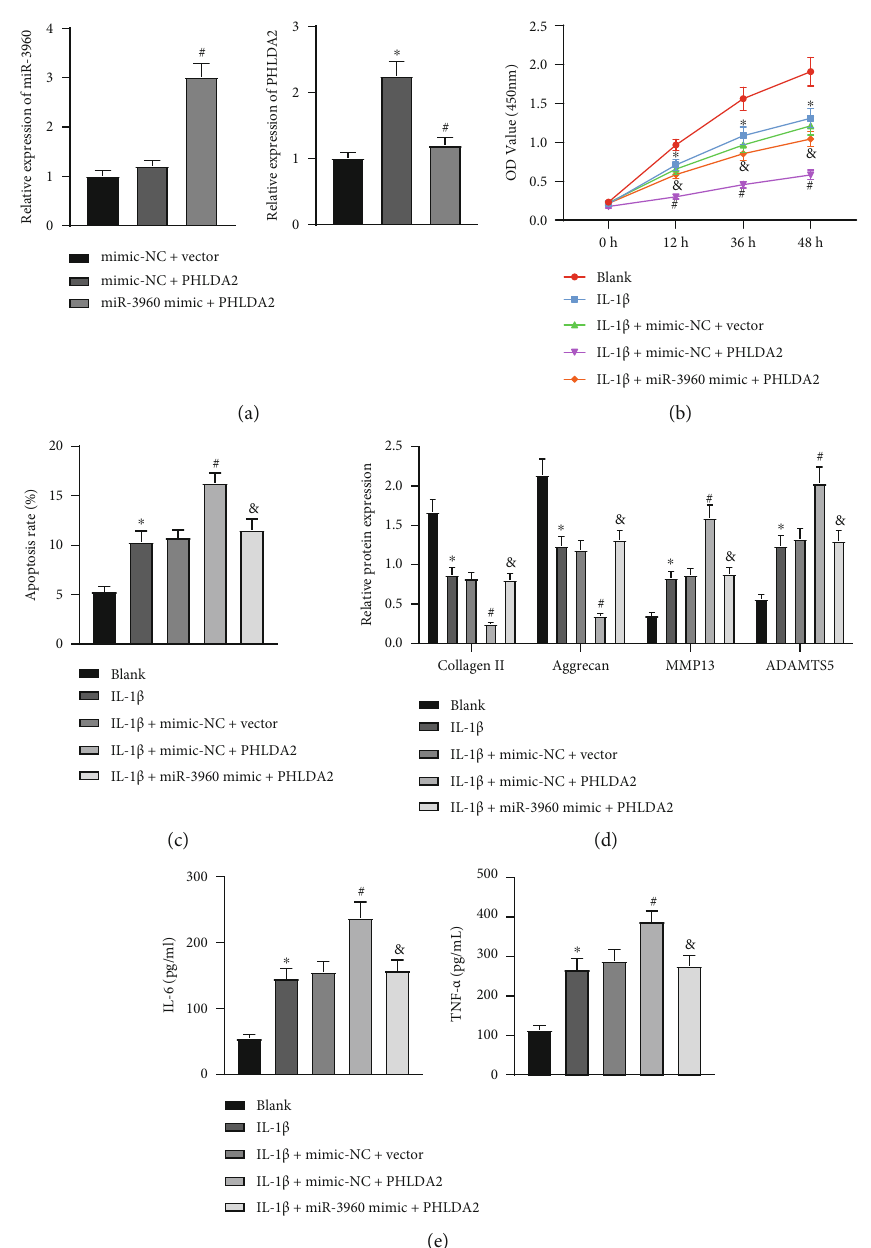
Figure 4: miR-3960 attenuates chondrocyte injury by inhibiting PHLDA2. Chondrocytes were transduced with miR-3960 mimic and/or PHLDA2A. (a) miR-3960 expression and PHLDA2 mRNA level in the chondrocytes determined by RT-qPCR. Chondrocytes were treated with IL-1 β and transduced with miR-3960 mimic and/or PHLDA2A. (b) Cell proliferation assessed by CCK8 assay. (c) Apoptosis assessed by fl ow cytometry. (d) Protein levels of collagen II, aggrecan, MMP13, and ADAMTS5 in the chondrocytes measured by immunoblotting. (e) Levels of IL-6 and TNF- α in the chondrocytes measured by ELISA. ∗ p < 0 : 05 vs. chondrocytes treated with mimic- NC+vector or chondrocytes without treatment; # p < 0 : 05 vs. chondrocytes treated with mimic-NC+PHLDA2 or chondrocytes treated with IL-1 β +mimic-NC+vector; & p < 0 : 05 vs. chondrocytes treated with IL-1 β +mimic-NC+PHLDA2. Data are shown as the mean ± standard deviation of three technical replicates. Data between two groups were compared by independent t -test. Data comparisons among multiple groups were analyzed by the one-way ANOVA with Tukey ’ s post hoc test, and comparison of data at di ff erent time points was analyzed using repeated measurement ANOVA with Tukey ’ s post hoc